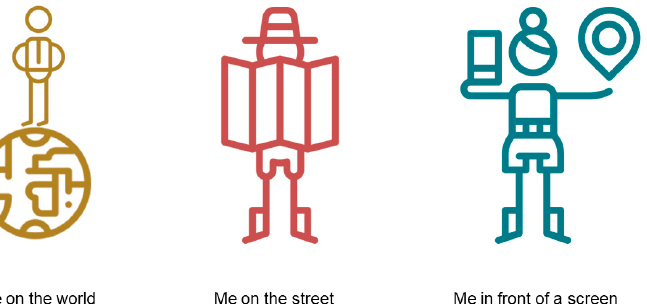
Figure 9. User profiles based on their proprioceptions and interactions with the system (figure is from the authors, designed using resources from [41]).